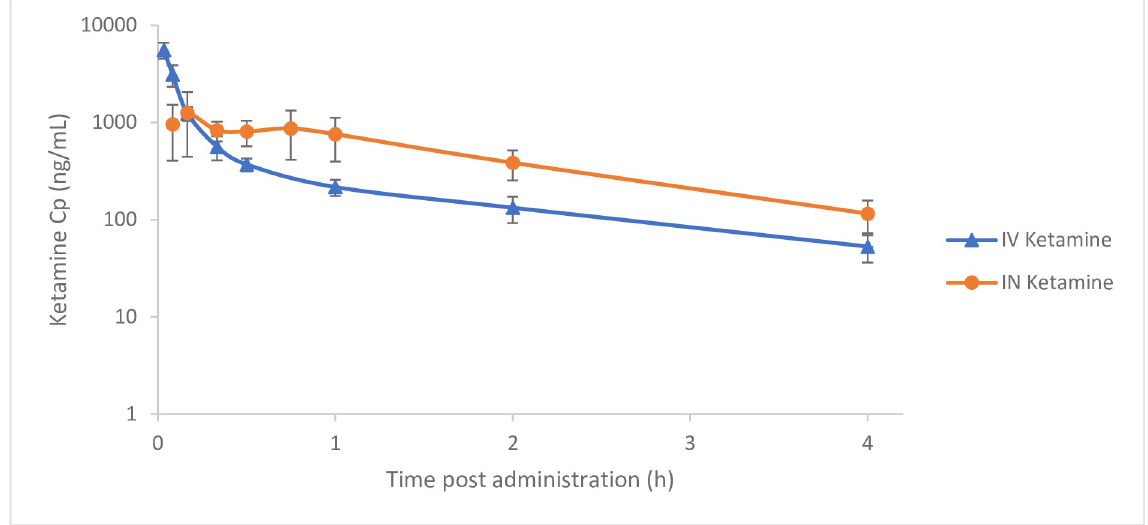
Fig 1. Mean plasma concentrations of ketamine in dogs administered a single dose of 2 mg/kg BW intravenously (IV) or intranasally (IN) (n = 7, mean ± SD).